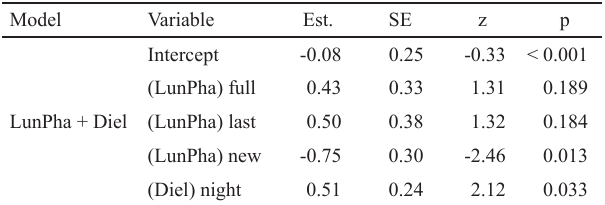
Fig. 3. UKFSST model of the Carcharhinus leucas movements along the Brazilian coast. The blue and pink points represent deployment and pop-up locations, respectively. The bathymetric profile and corresponding months of each geolocation are represented by the color scales. The dashed orange line represents the most probable track of the shark. The red shaded areas depict the confidence intervals of the model positions. Tab. 2. Generalized additive model of the time spent at the sea surface. Included are the predictor variables lunar phase (LunPha) and diel cycle (Diel), the coefficient estimate (Est.), standard errors (SE), z-statistics (z) and corresponding p -values (p).